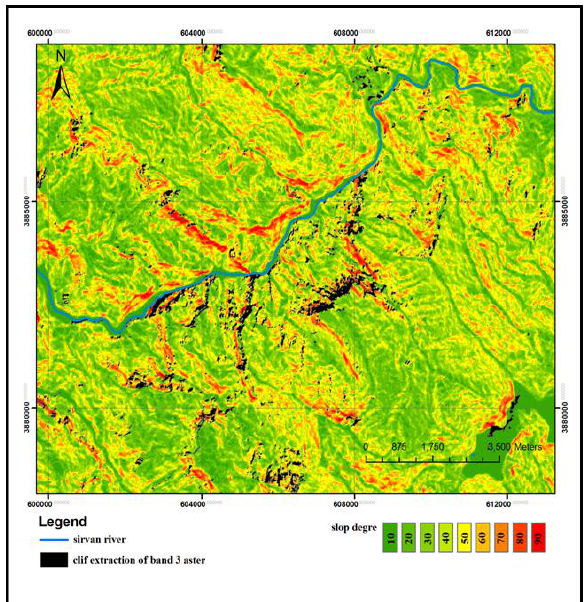
Fig 8. Cuesta map obtained in the study